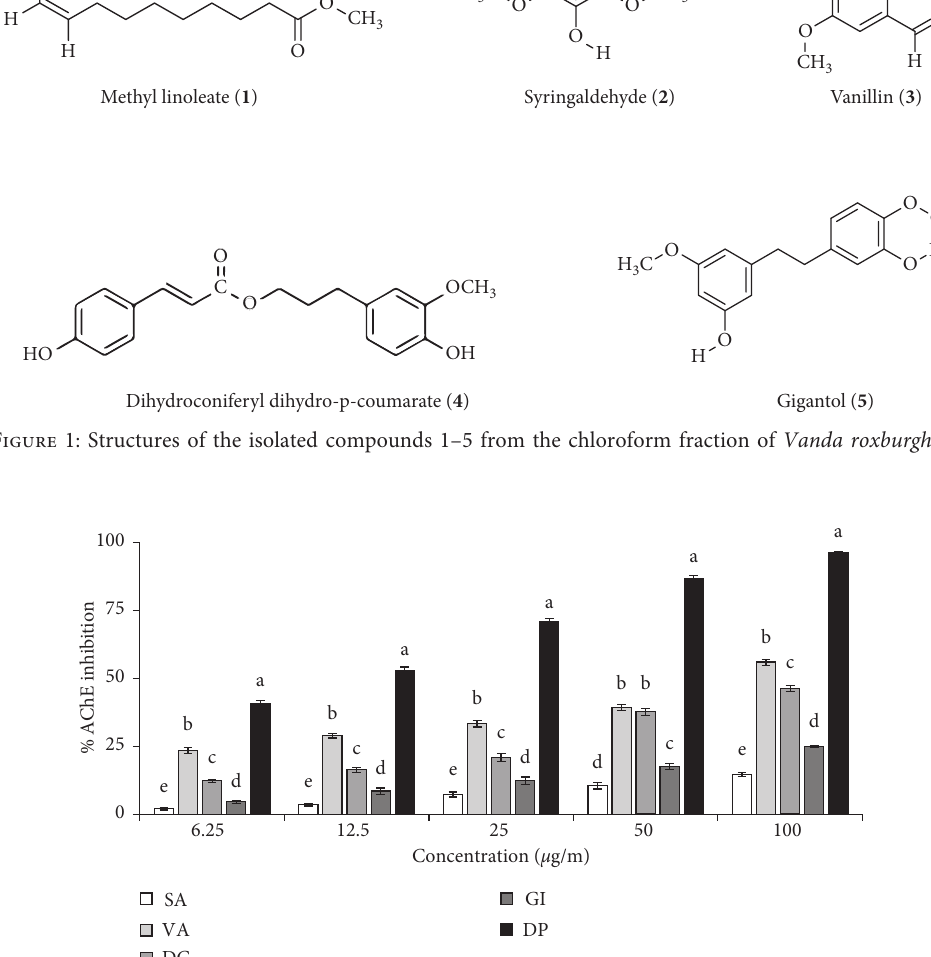
Methyl linoleate ( 1 )